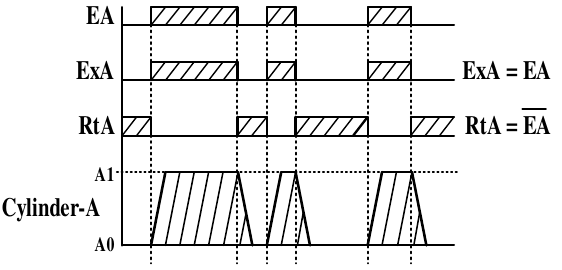
Fig. 8. Step Time Diagramof Cylinder-A Manual